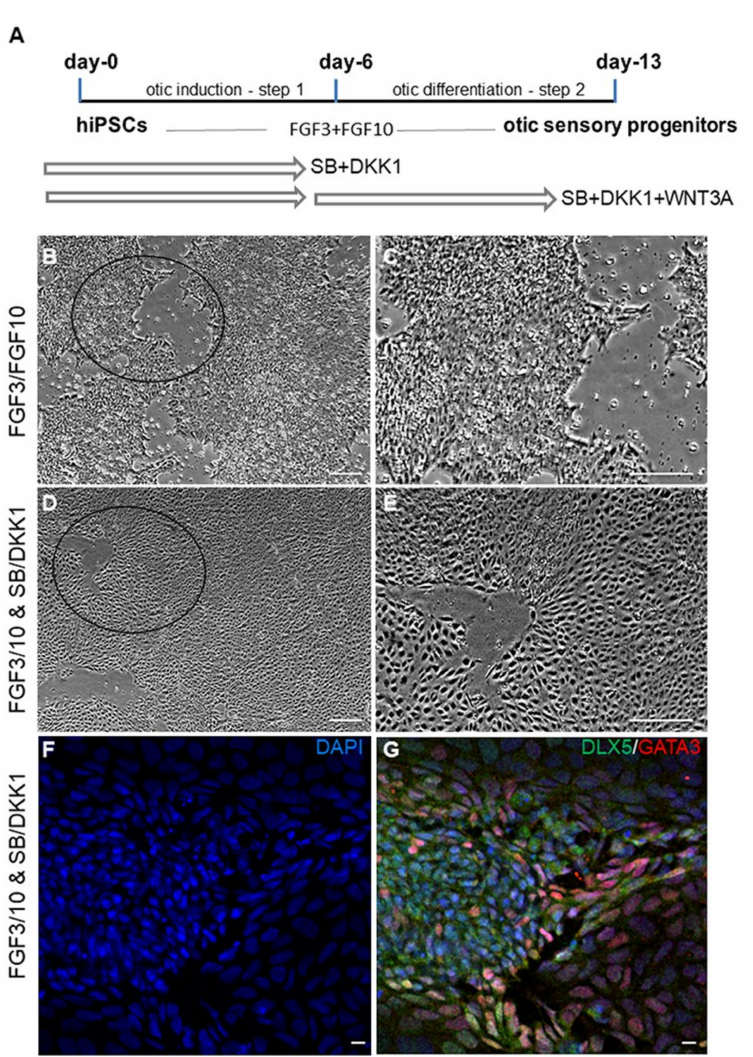
Figure 1. Schematic representation outlining the timeline and culture conditions for otic sensory differentiation from hiPSCs. ( A ) In a first step, undifferentiated hiPSCs were exposed to FGF3/FGF10 growth factors and SB for early otic/placodal induction until day 6 in vitro and, in a second step, they were differentiated into otic sensory cells by exposure to FGF3/10, DKK1/SB and WNT3A until day 13 in vitro. ( B , C ) Phase-contrast representative images showing the morphological character- istics of hiPSC-derived otic progenitors exposed to FGF3/10. ( C ) A magnification from the area indicated by a circle in ( B ). ( D , E ) Phase-contrast images showing the morphological characteristics of hiPSC-derived otic progenitors exposed to FGF3/10 + DKK1/SB. ( E ) A magnification from the area indicated by a circle in ( D ) showing that partially differentiated hiPSCs at day 6 displayed a homogeneous morphological appearance after exposition to FGF3/10 and SB/DKK1 treatments when compared to the cell cultures exposed only to FGF3/10 ( B , C ). ( F , G ) Representative immunos- tainings for the early otic markers DLX5 and GATA3 in day 6 FGF3/10/SB/DKK1-treated cultures. The immunostaining of GATA3 (shown in red) and DLX5 (shown in green) is detected in a subset of differentiated otic/placodal cells. DAPI staining is shown in blue. Scale bars = 200 µ m ( B – E ); 20 µ m ( F , G ). Abbreviations: FGF: fibroblast growth factor; SB-431542: TGF β pathway inhibitor; Dkk1: Dickkopf-related protein-1: WNT pathway inhibitor. WNT3A: Recombinant human WNT